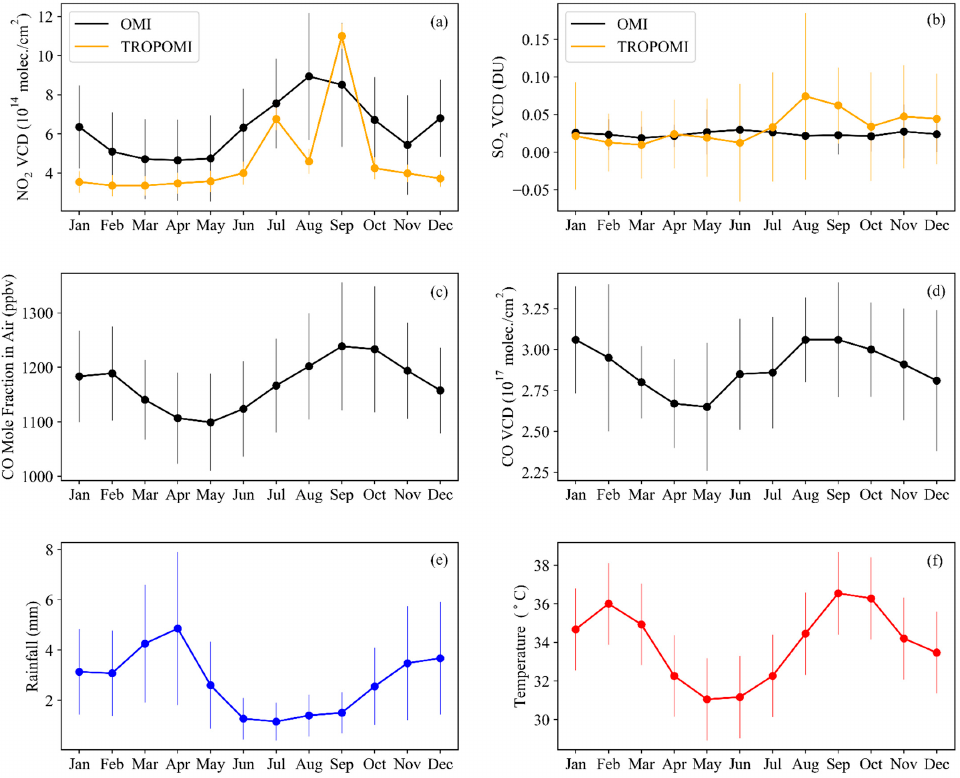
Figure 3. Seasonal variation of NO 2 ( a ), SO 2 ( b ), CO ( c , d ) along with rainfall ( e ) and temperature ( f ). The vertical bars show the monthly standard deviations.